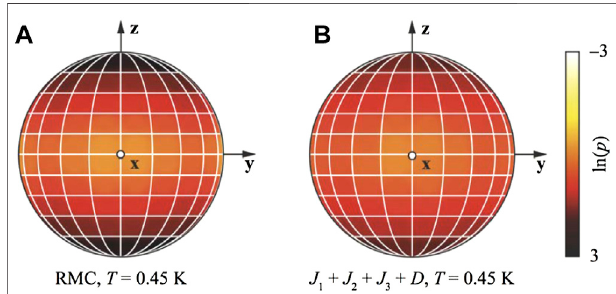
FIGURE 9 | Stereographic projections of the logarithmic probability distribution function of spin orientations obtained by (A) RMC re fi nement against experimental powder neutron-scattering data collected at T = 0.450 K, and (B) direct Monte Carlo simulation of the spin Hamiltonian proposed for GGG at T = 0.45 K 13 ,